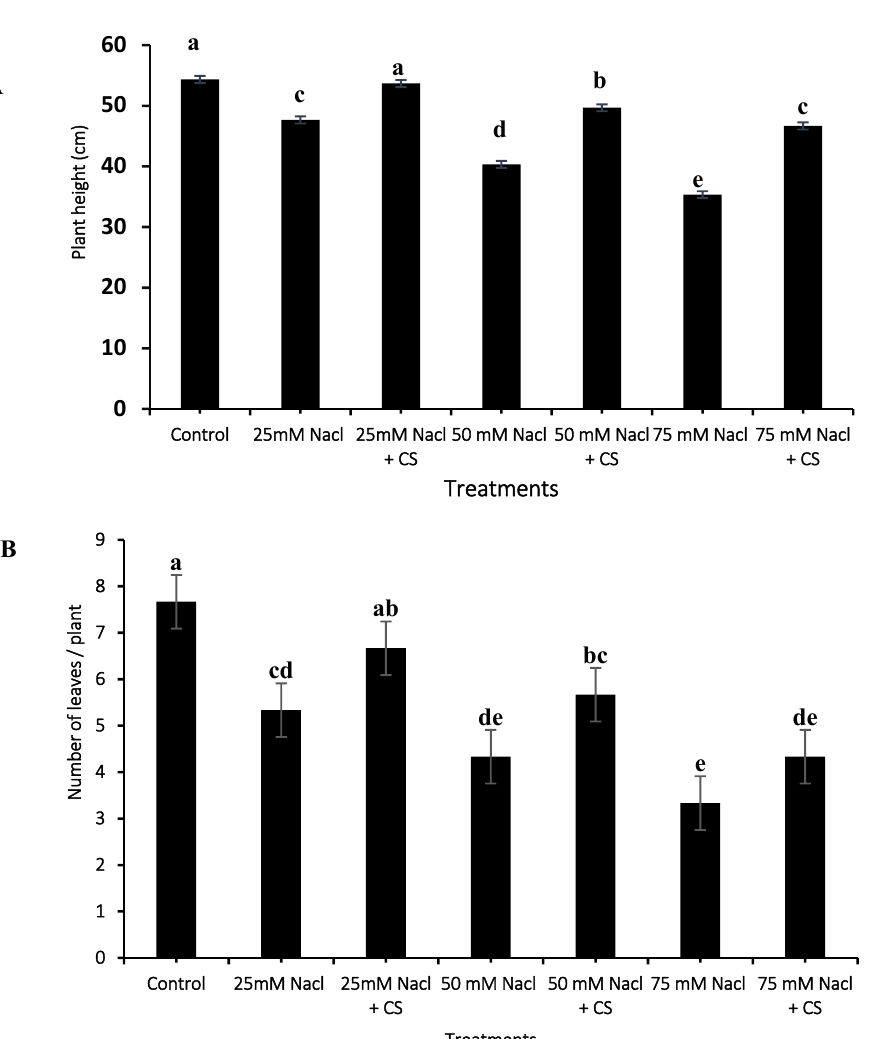
Figure 1. Plant height ( A ) and number of leaves per plant ( B ) of Moringa oleifera exposed to salt stress and sprayed with chitosan (CS) at 1% concentration. Values are means ± SD of two experiments ( n = 6). Columns with different letters are statistically different from each other according to LSD test at p ≤ 0.05.